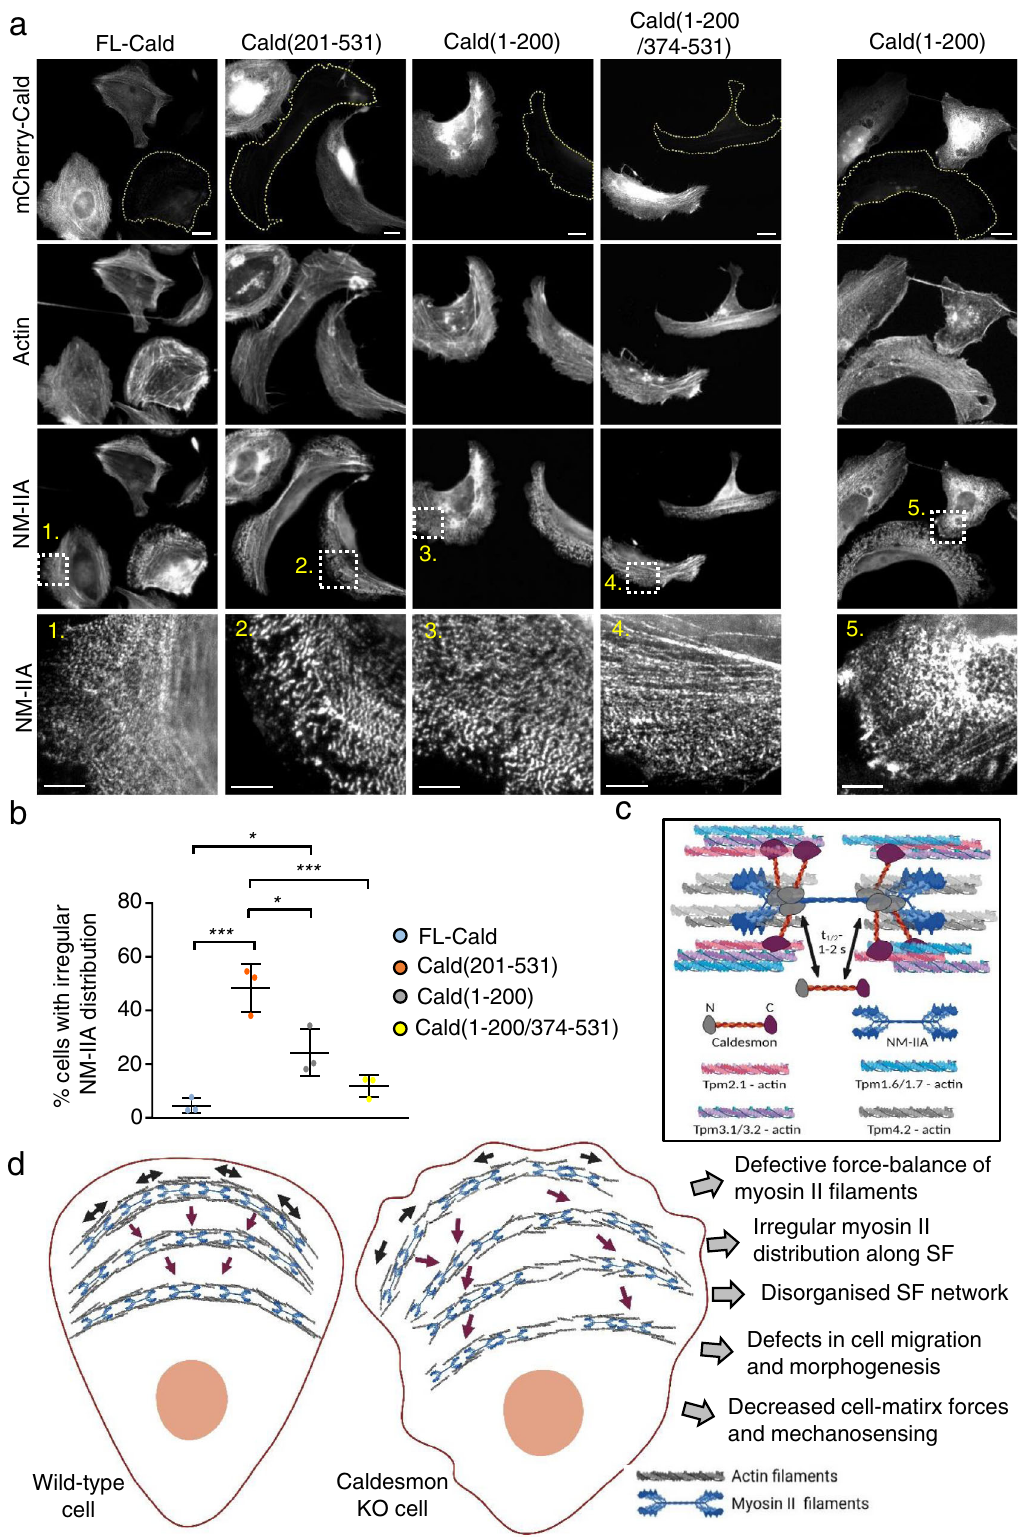
(0.05% Tween-20) followed by probing with primary antibody against phospho- and total-proteins on overnight shaking at 4 °C. The blots werewashedthreetimesin0.05%TBS-Tandincubatedwithrespective HRP-conjugate secondary antibodies for 1 h at RT. Finally, the blots were washed and protein bands were detected using WesternBright ™ ECL-spray (K-12049-D50, Advansta) in the ChemiDoc XRS+System